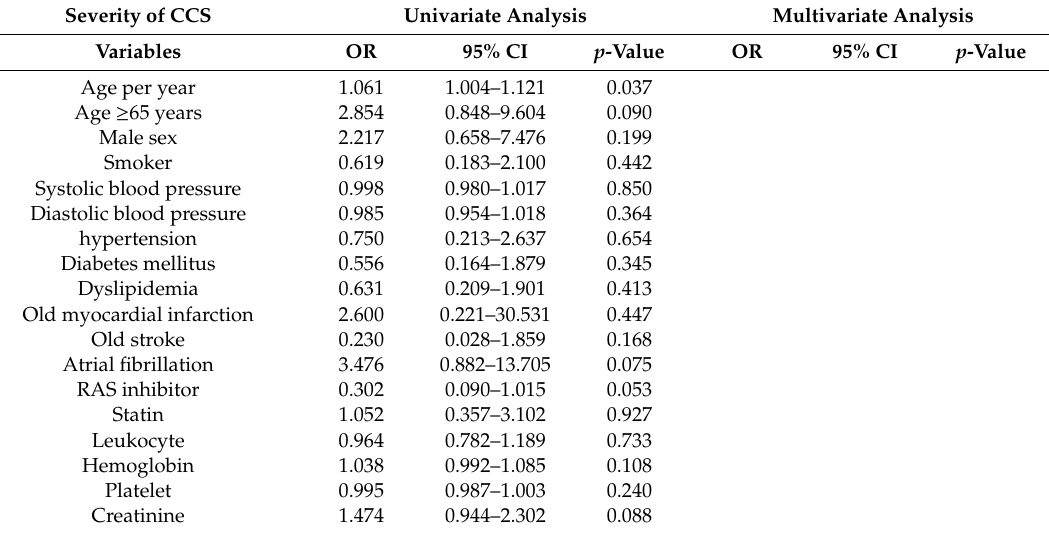
Table 5. Predictors of the moderate to severe CCS (NIHSS > 8 and LVEF <